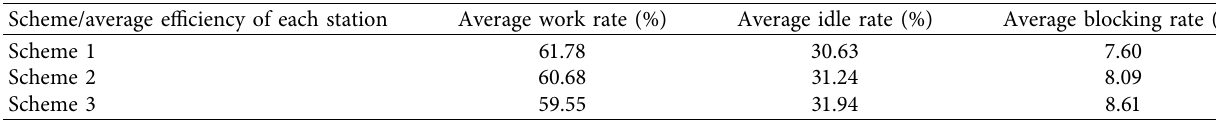
Figure 4: Comparison of sound insulation between different materials of light roof and actual vehicle conditions. Table 2: Average efficiency of each station.